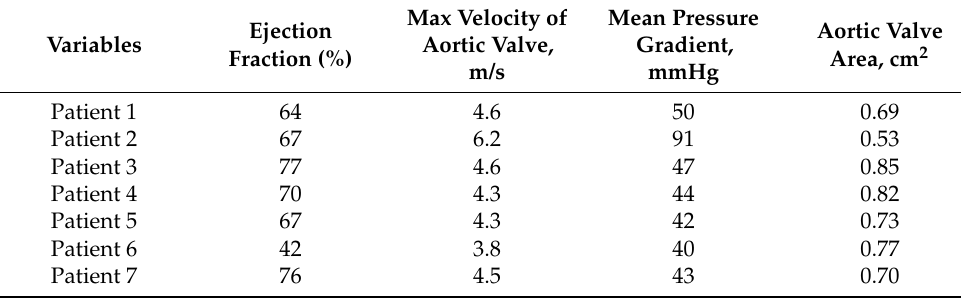
Table 2. Echocardiographic Data of